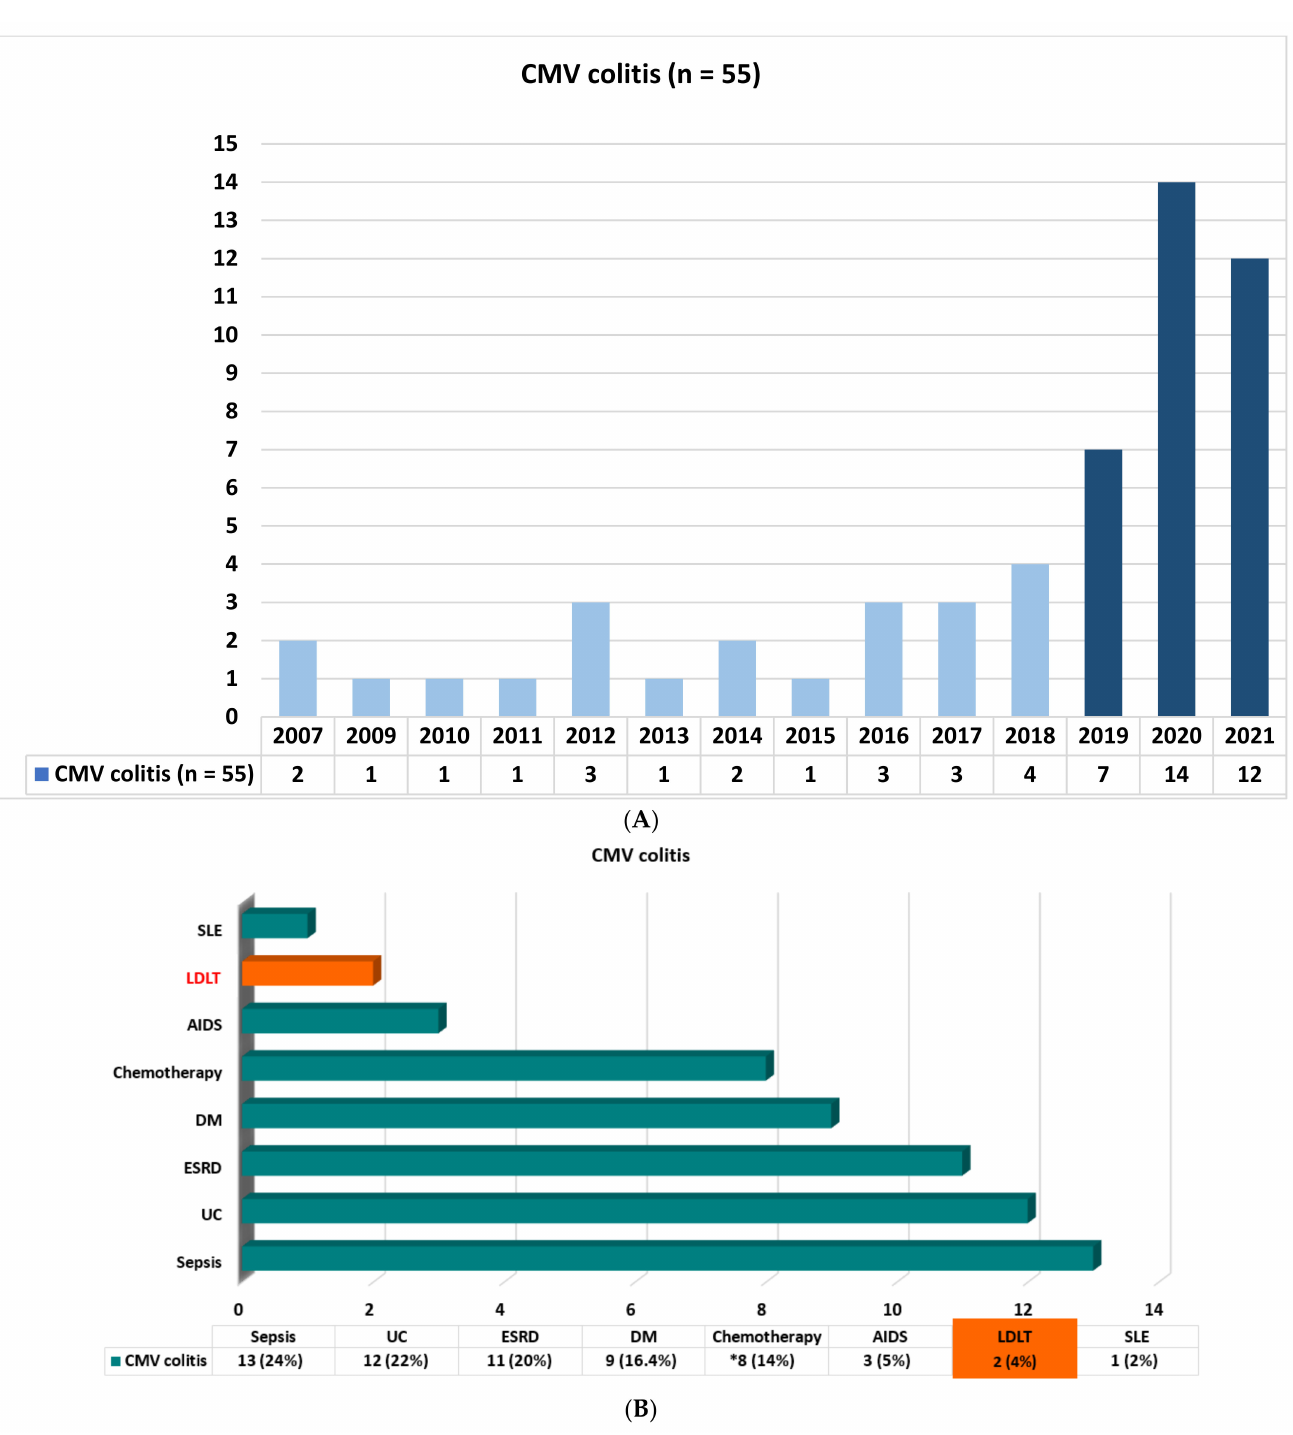
Figure 1. ( A ) Biopsy-proven cytomegalovirus colitis from 2007 to 2021. ( B ) Demographic characteris- tics of all patients with biopsy-proven cytomegalovirus colitis. UC: ulcerative colitis; ESRD: end stage renal disease; DM: diabetes mellitus; AIDS: acquired immunodeficiency syndrome; LDLT: living donor liver transplantation; SLE: systemic lupus erythematosus; *: chemotherapy for colon cancer (n = 2, 3.6%), cancer of non-gastrointestinal tract (n = 6, 10.9%). The clinical characteristics, laboratory test, pathology findings, and treatment of all patients with biopsy-proven cytomegalovirus colitis are shown in Table 1. Among the 55 eligible patients, the mean age was 68 years. Male gender and female gender